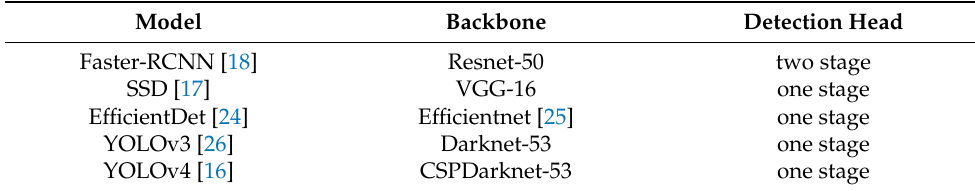
Table 2. Object detection methods of UAV